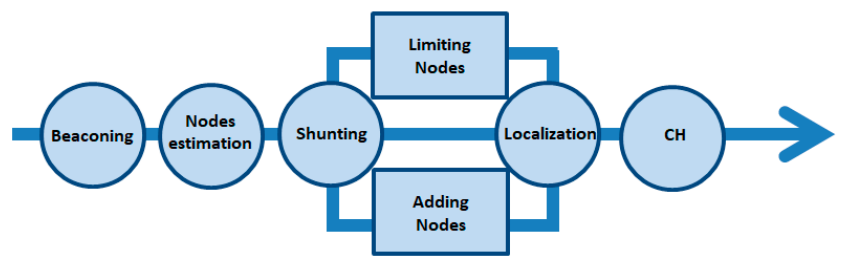
Figure 6. UAV discovery phase.